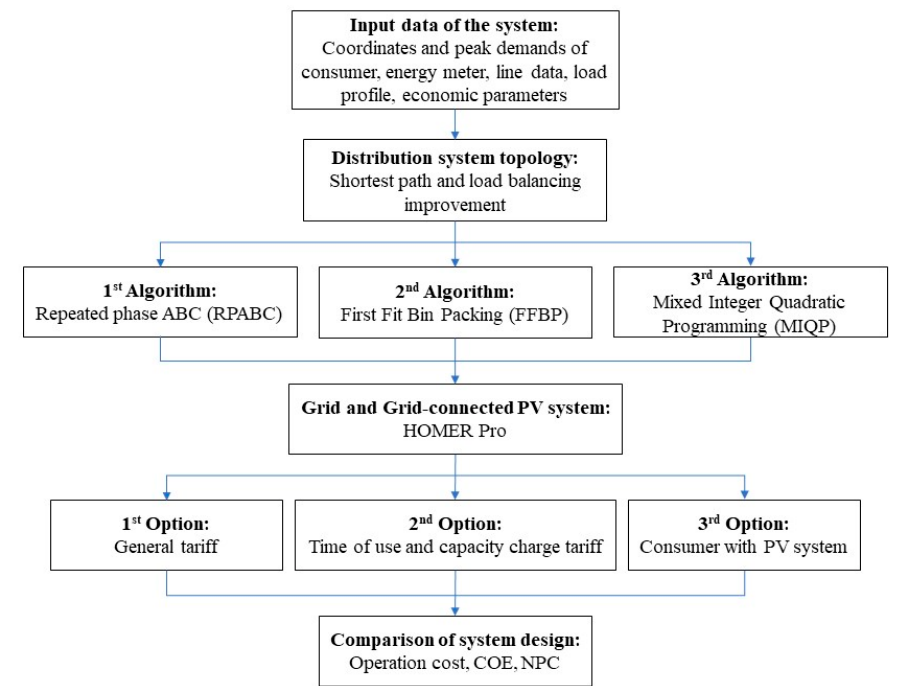
Figure 1. Flowchart of the proposed method.